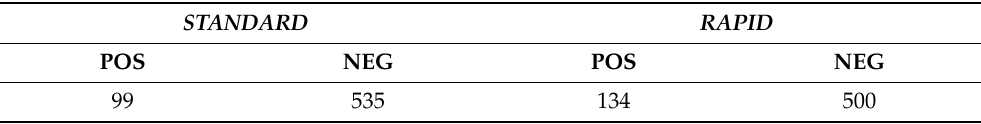
Table 3. Comparison of IC detection, by qPCR, between 634 samples extracted in parallel with the standard and rapid kits. The Ct average and standard deviation parameters are reported. IC Ct Kit Average Standard Rapid 28.5 1.53 In terms of SARS-CoV-2 detection, the SARS-CoV-2 gene quantification by qPCR showed some differences between the samples extracted by the different kits. Table 4 provides a summary of the results based on the qPCR kit datasheet that considers SARS-CoV-2 samples to be positive (one of the two genes ORF8 or RdRp). Table 4. Summary of SARS-CoV-2 detection by qPCR using the standard and rapid kits for RNA isolation.